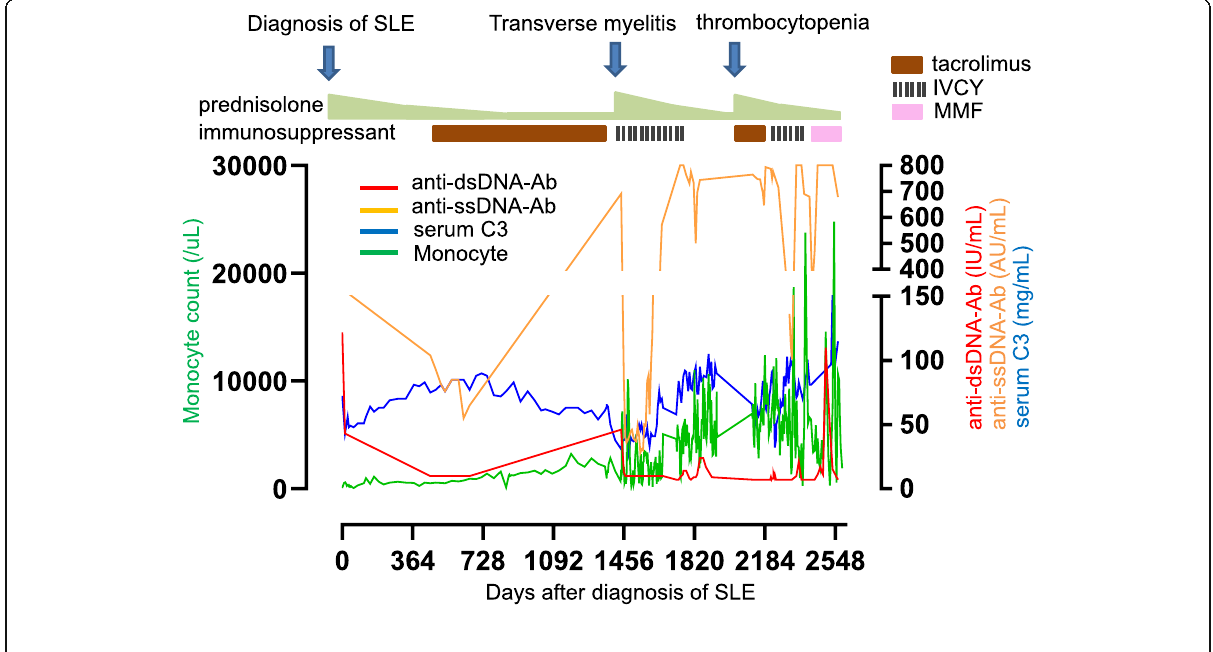
Fig. 1 Graph depicts clinical course of the current case. Monocyte count, levels of anti-dsDNA antibody, anti-ssDNA-Ab, and serum C3 of the patient are shown in the graph. Diagnosis and the respective treatment measures are depicted on top of the